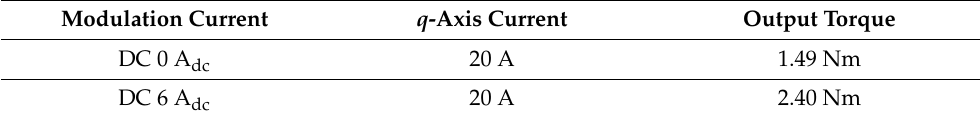
Table 7. Comparison of output torque.